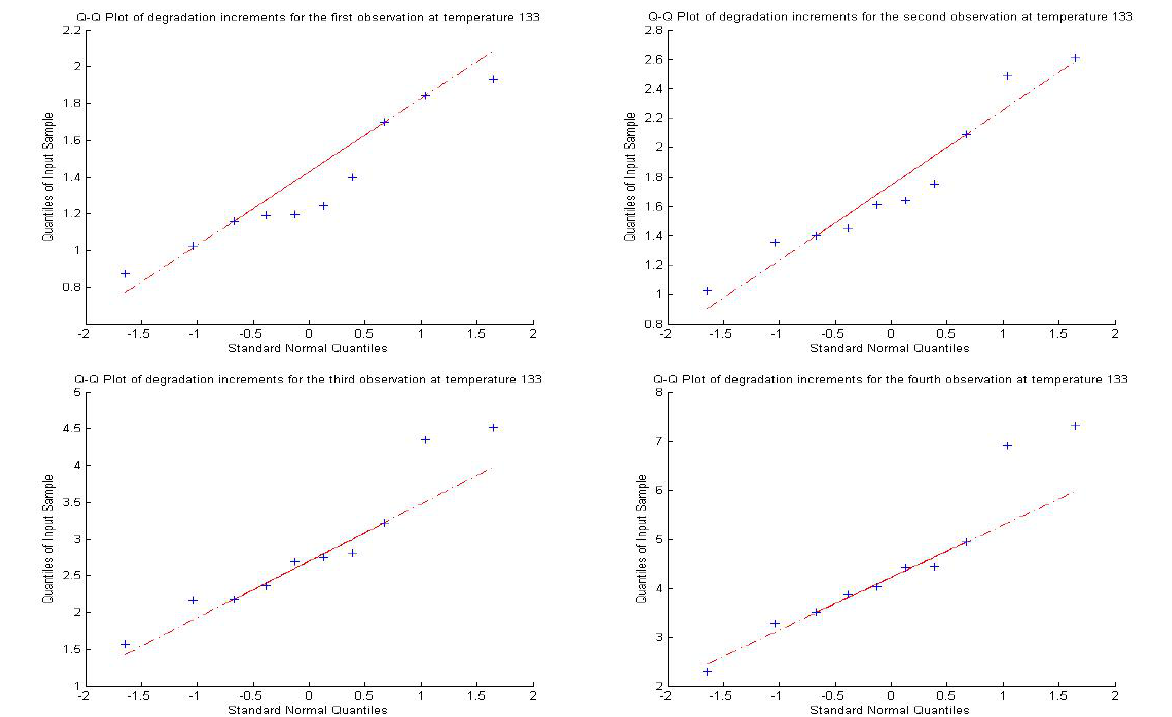
Figure 3. The Q-Q plot for degradation data at temperature 133 ◦ C.